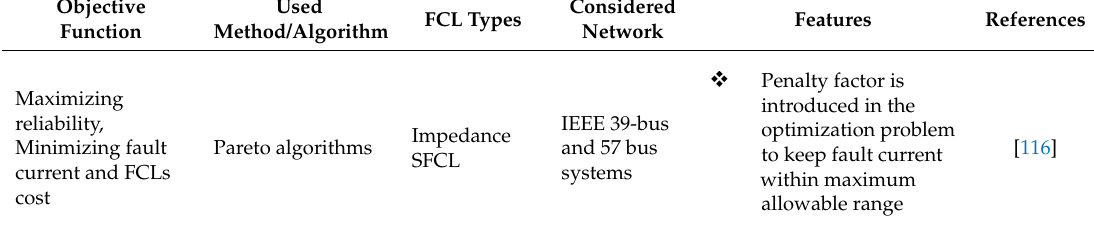
Figure 4. The phases for implementing a N-AHP in SWOT analysis.